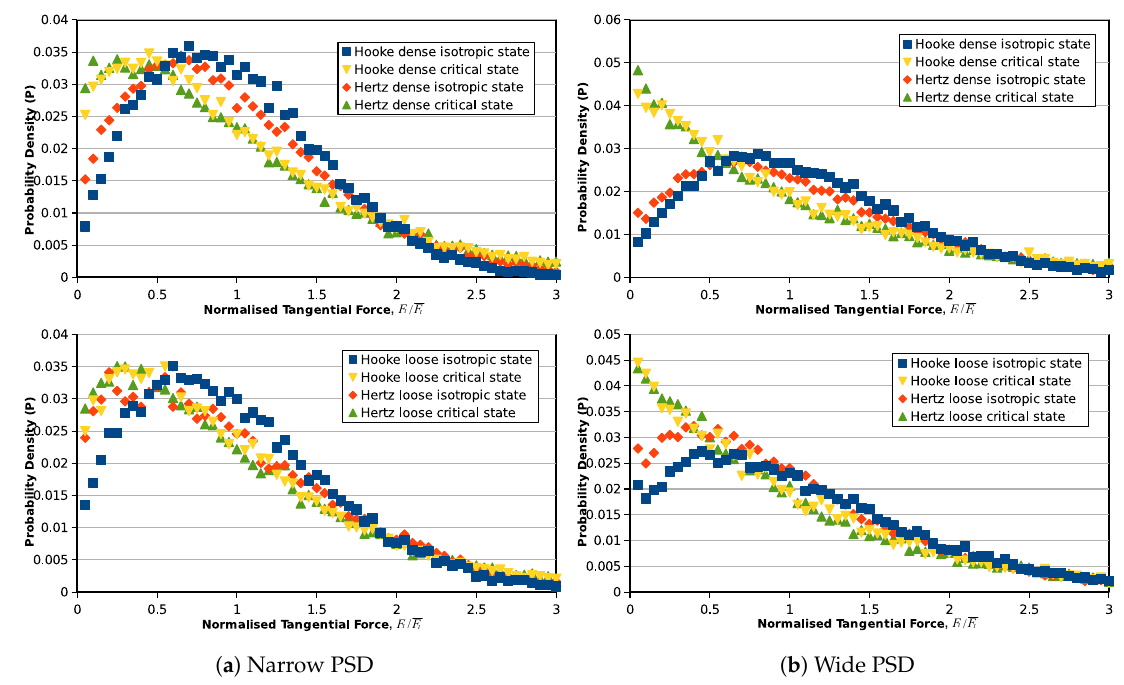
Figure 7. Probability density distribution of normalized tangential contact forces ( F t / ¯ F t